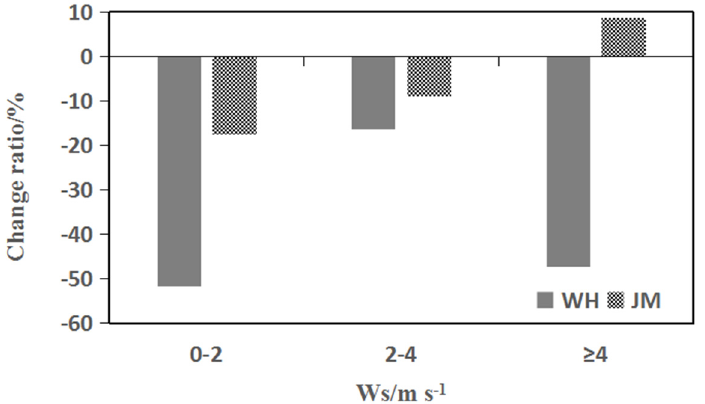
Figure 6. The percentage reduction in the PM 2.5 concentration anomaly of the first eigenvectors in WH and JM under different wind speed conditions during the COVID-19 pandemic.